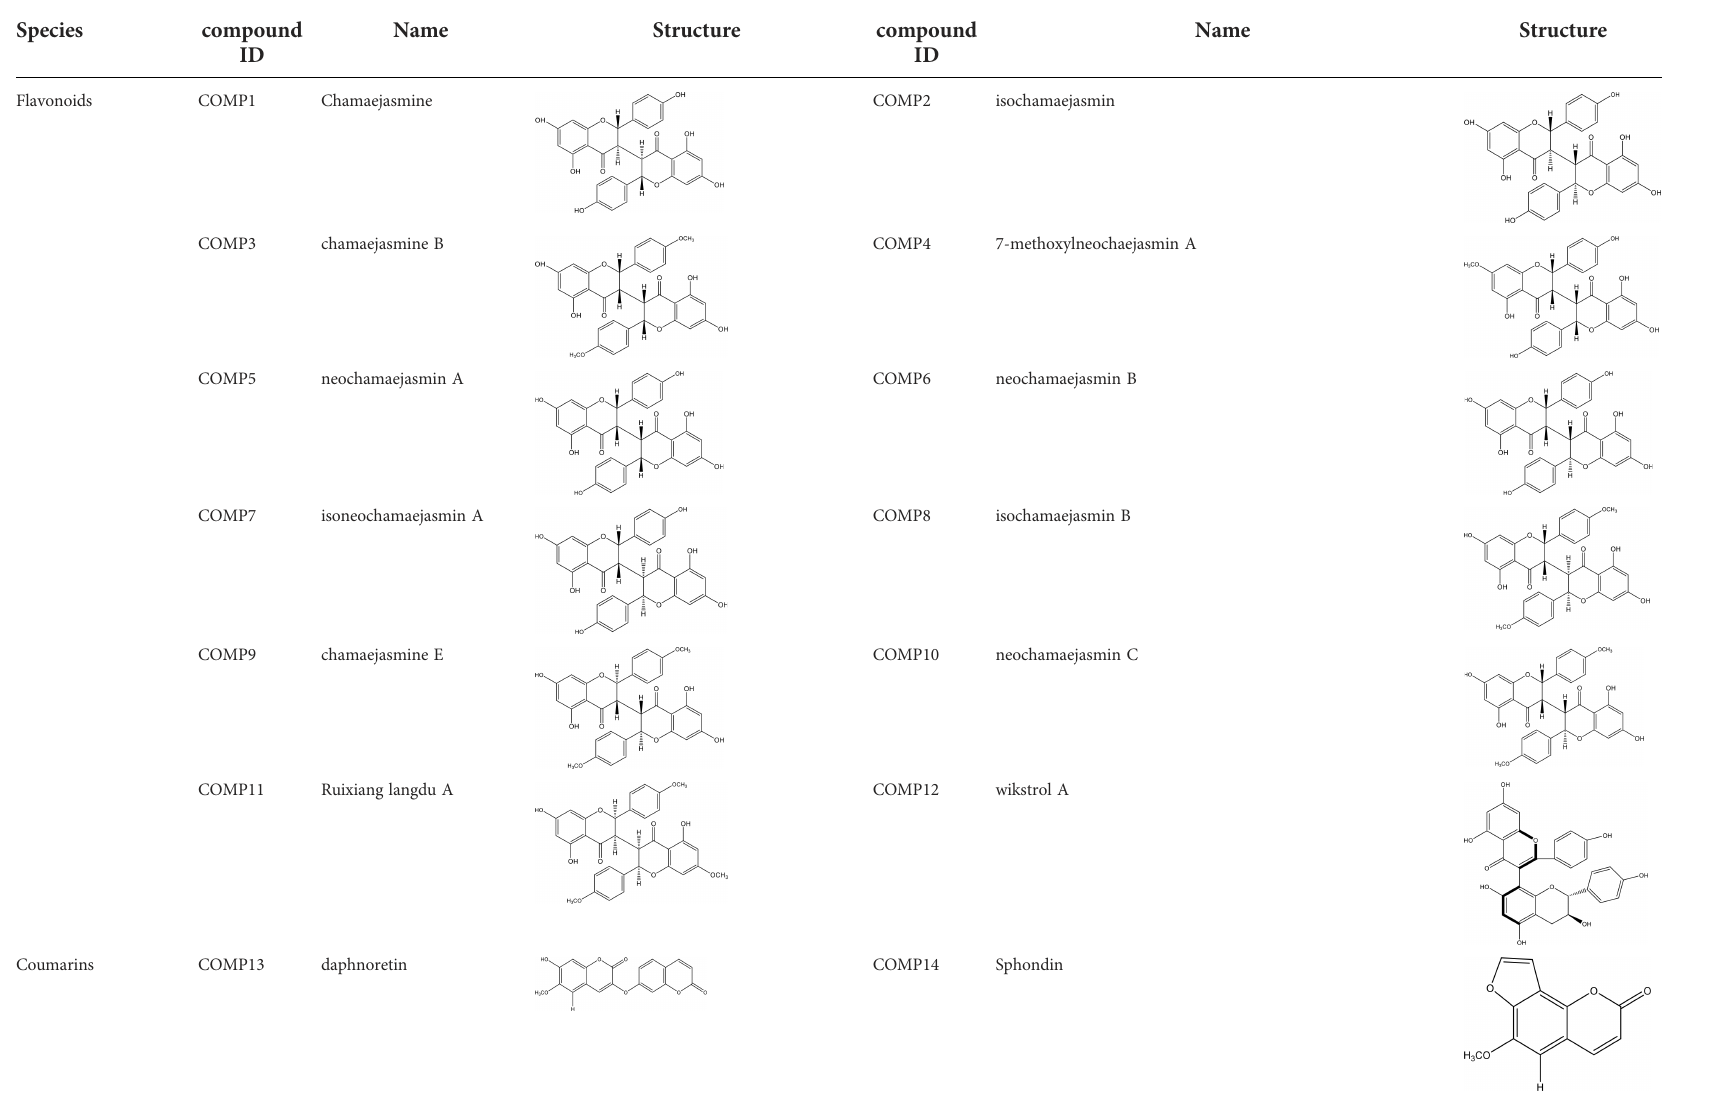
TABLE 1 Active ingredients identi fi ed in RXLD and their chemical structures (NormFit ≧